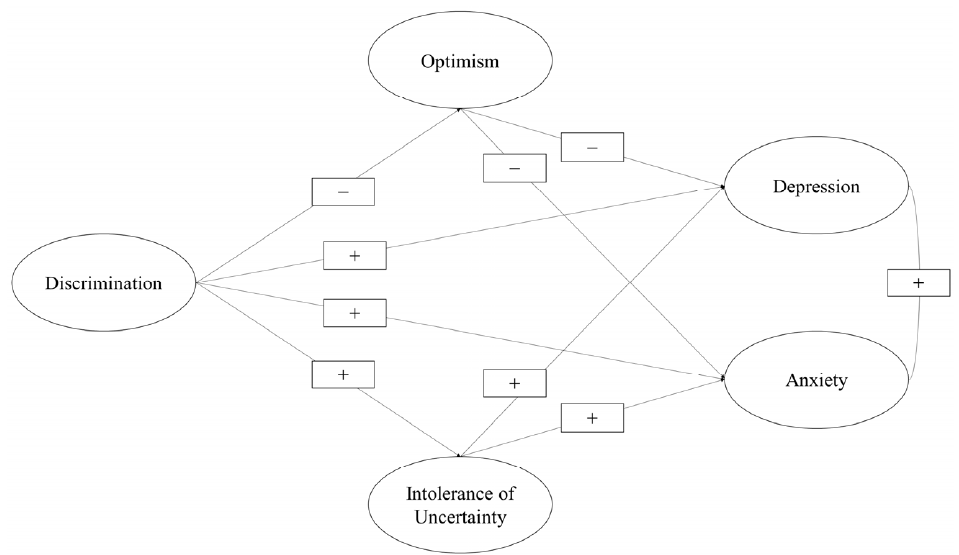
Figure 2. Effects of optimism and intolerance of uncertainty on the relationship between discrimination and depression and anxiety.